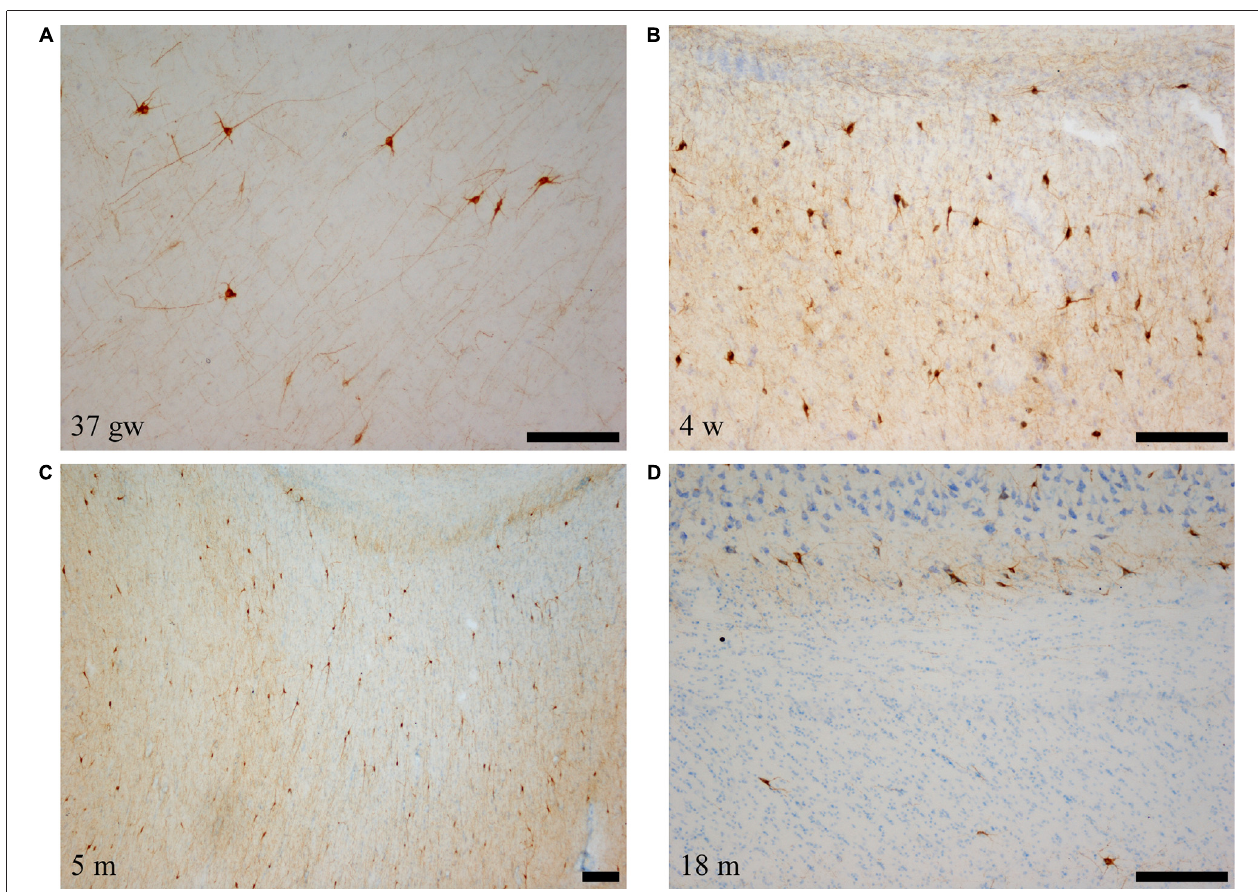
FIGURE 5 | Low power photomicrographs of the distribution of SOM-28-immunoreactive neurons in the angular bundle at increasing ages. Panel (A) is a 37 gestational week (gw) case showing multipolar, neurons, dendrites as well as immunostained fibers deep in the angular bundle. Panel (B) shows the concentration of stained neurons at the border with the entorhinal cortex (EC; to the right in the panel). Panel (C) shows that the density of labeled neurons is still high at 5 months, while panel (D) shows that, by 18 months, the apparent density is clearly lower. Topographically, panels (B,C) are at the rostral portion of the angular bundle; panels (A,D) correspond to caudal levels of the hippocampus. Scale bar is 200 µ